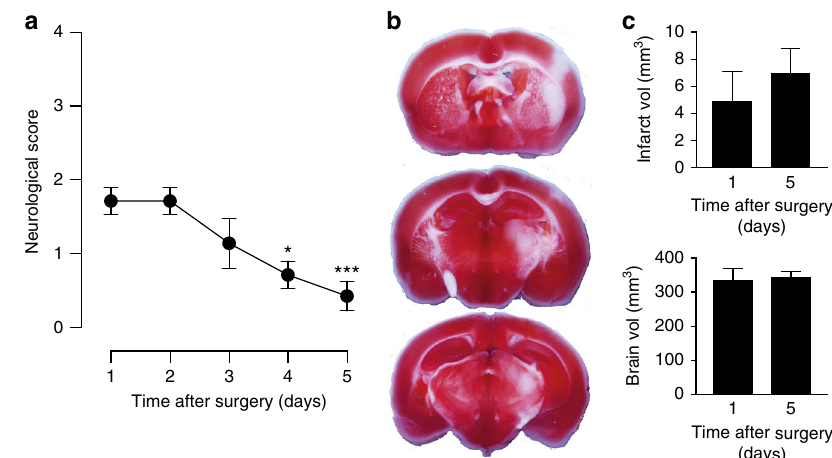
Fig. 2 Improvement of functional de fi cits over 5 days after 90 min of transient MCAO in tau − / − mice. a Neurological impairments of tau − / − mice after 90 min of transient MCAO progressively improved over 5 days after the procedure (* p < 0.05; *** p < 0.001; N = 8; one-way ANOVA (Turkey post hoc)). b Example of a maximum infarct area 5 days after transient MCAO in tau − / − mice. TTC stains viable brain tissue in serial sections red . c Volumetric analysis showed similar infarct volumes 24 h and 5 days after MCAO (not signi fi cant; N = 12 (day 1), N = 8 (day 5); Student ’ s t -test). All error bars are